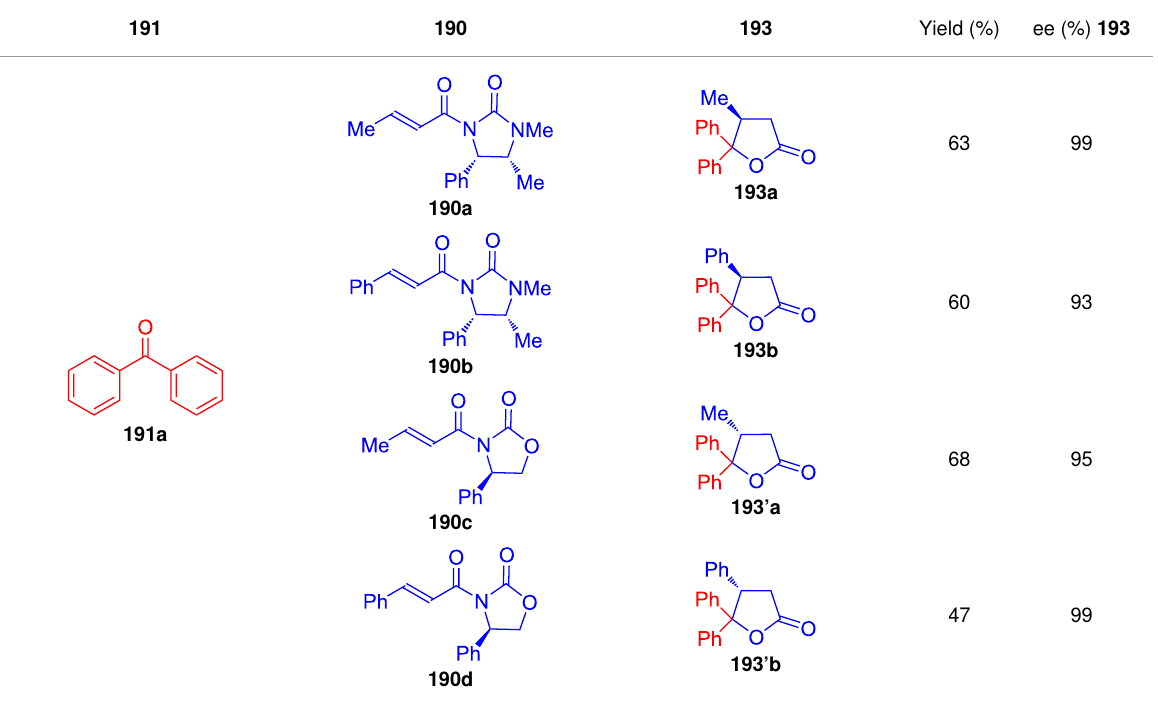
Table 1: Enantioselective electroreductive coupling of diaryl ketones with α , β -unsaturated carbonyl compounds containing chiral